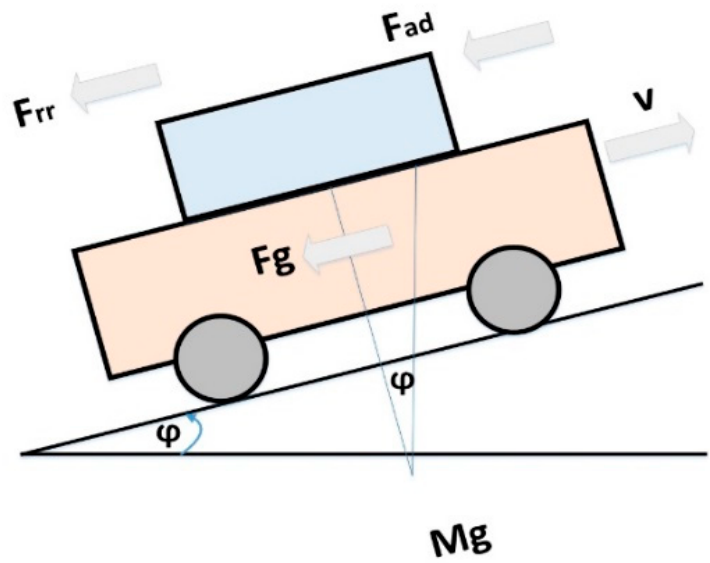
Figure 2. Schematic of external obstacles affecting a running EV [7].